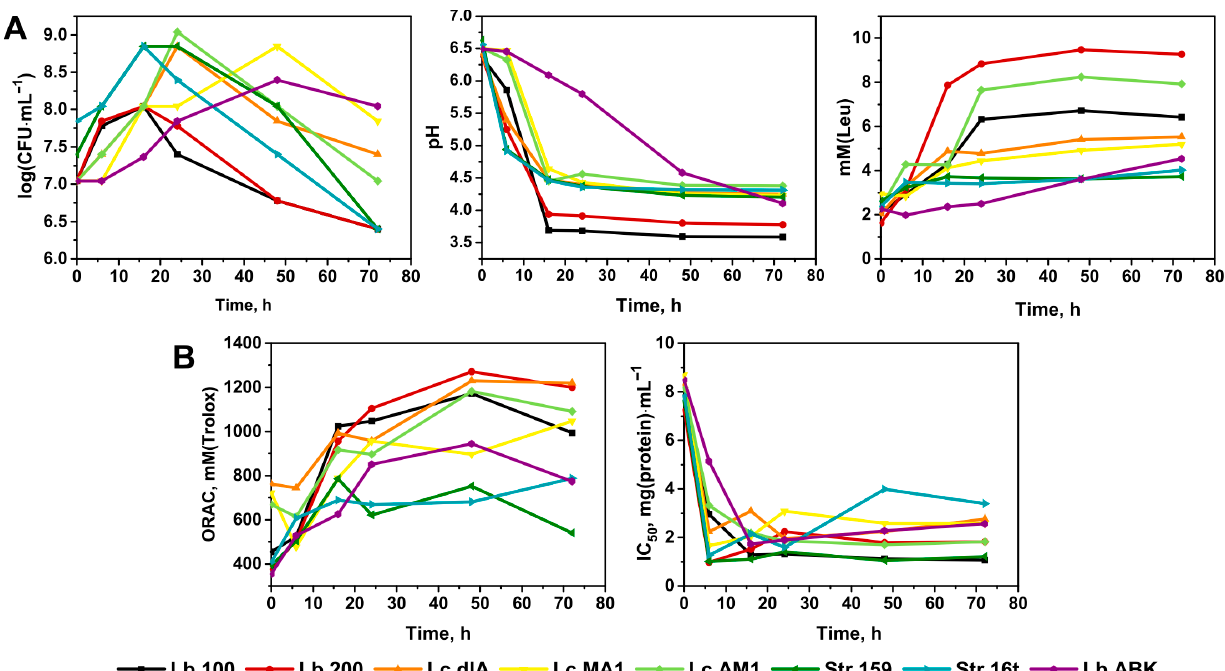
Figure 1. ( A )—The general fermentation parameters of the screened strains of lactic acid bacteria; ( B )—The development of antioxidant and ACE-I activities in the milk fermented by the screened strains of LAB. Strains of Lactobacillus delbrueckii and Lacticaseibacillus paracasei are abbreviated as Lb; strains of Lactococcus lactis and Streptococcus thermophilus are abbreviated as Lc and Str, respectively. For all datapoints the standard error from three biological replicas did not exceed 5%.